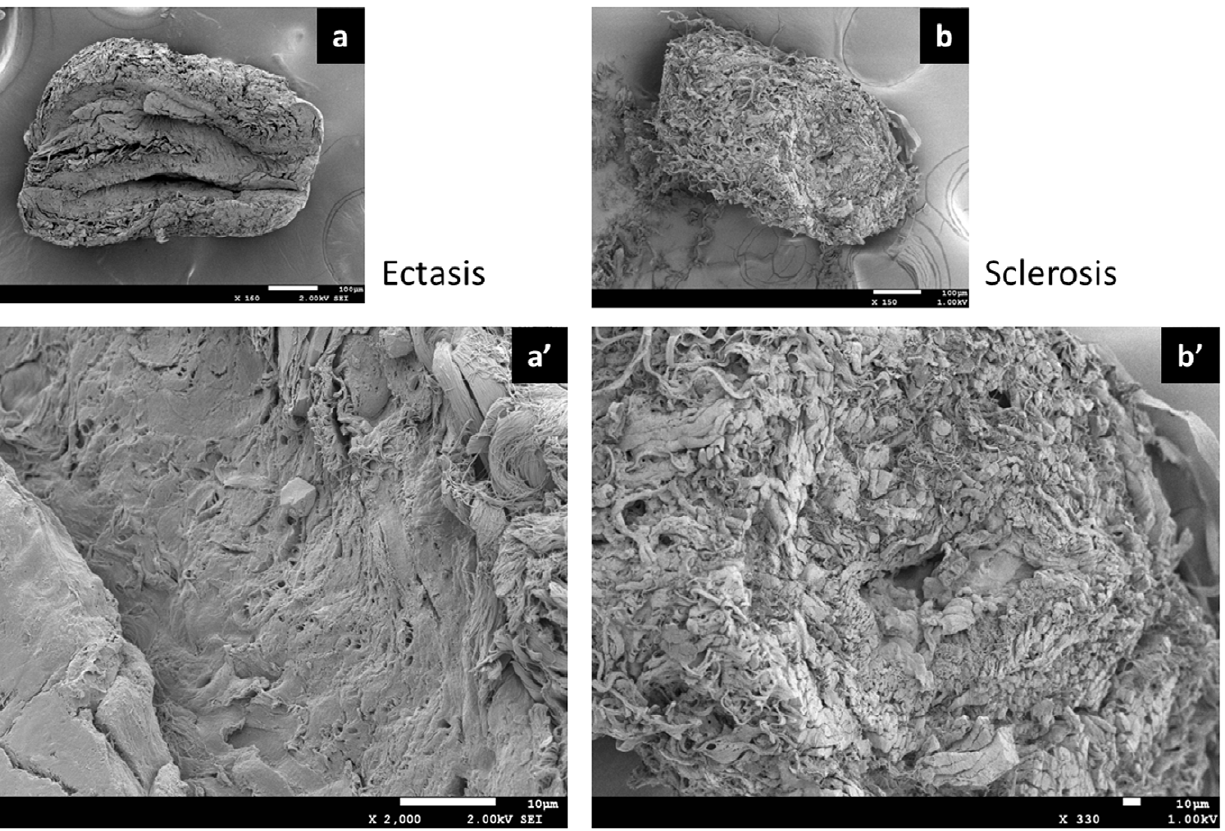
Figure 8. Electron microscopic and SEM findings. (a) Normal type. Bar=100 m m. (a’) Ectasis type. The lymphatic vessel lumen was dilated and entirely covered with lymphatic vessel endothelial cells. Bar=10 m m. (b) Sclerosis type. Bar=100 m m. (b’) The lymphatic vessel wall was thickened because of the hyperplasia of smooth muscles and collagen fibers. The lymphatic vessel lumen was narrowed and as shaped like a pinhole. Bar=10 m m.